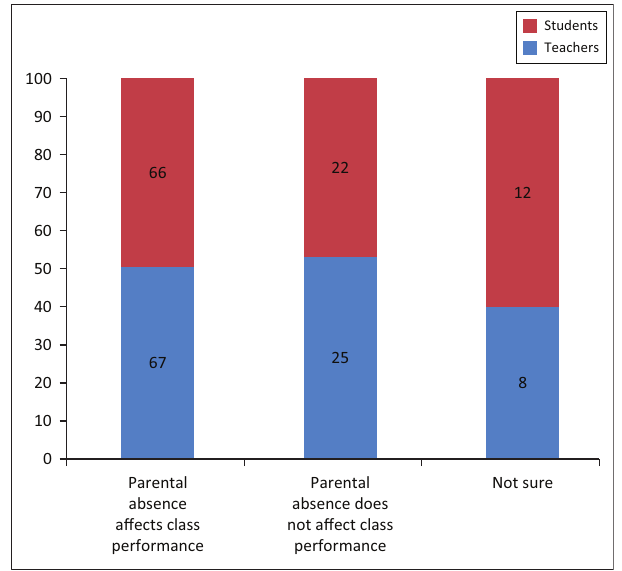
FIGURE 4: Parental migration and students’ class